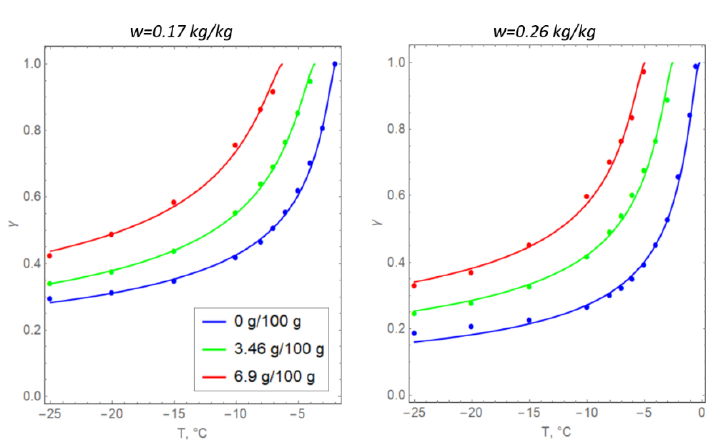
Figure 3. Temperature dependences of the volume fraction of unfrozen water in argillite-like clay samples: solid lines represent theoretical dependence (6) and dots represent the experimental data.